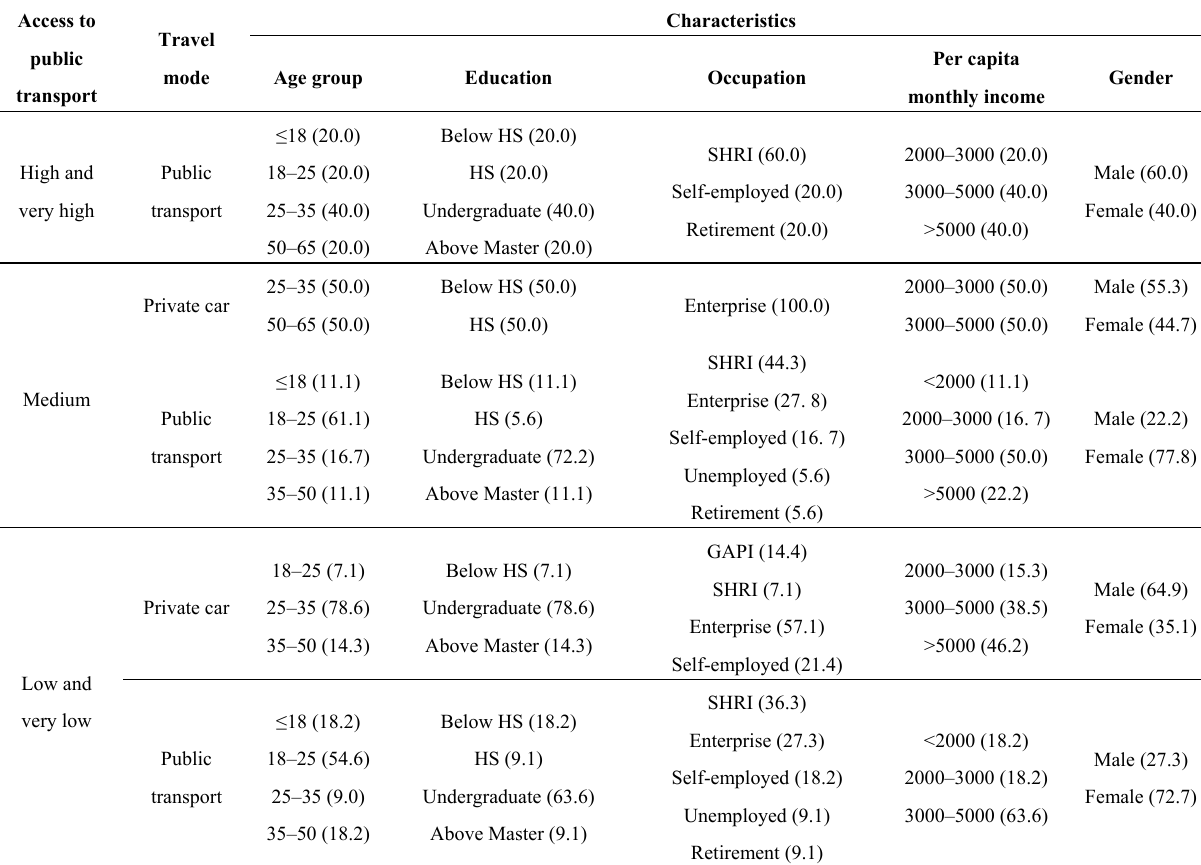
Table 5. Characteristics of car owners on weekends